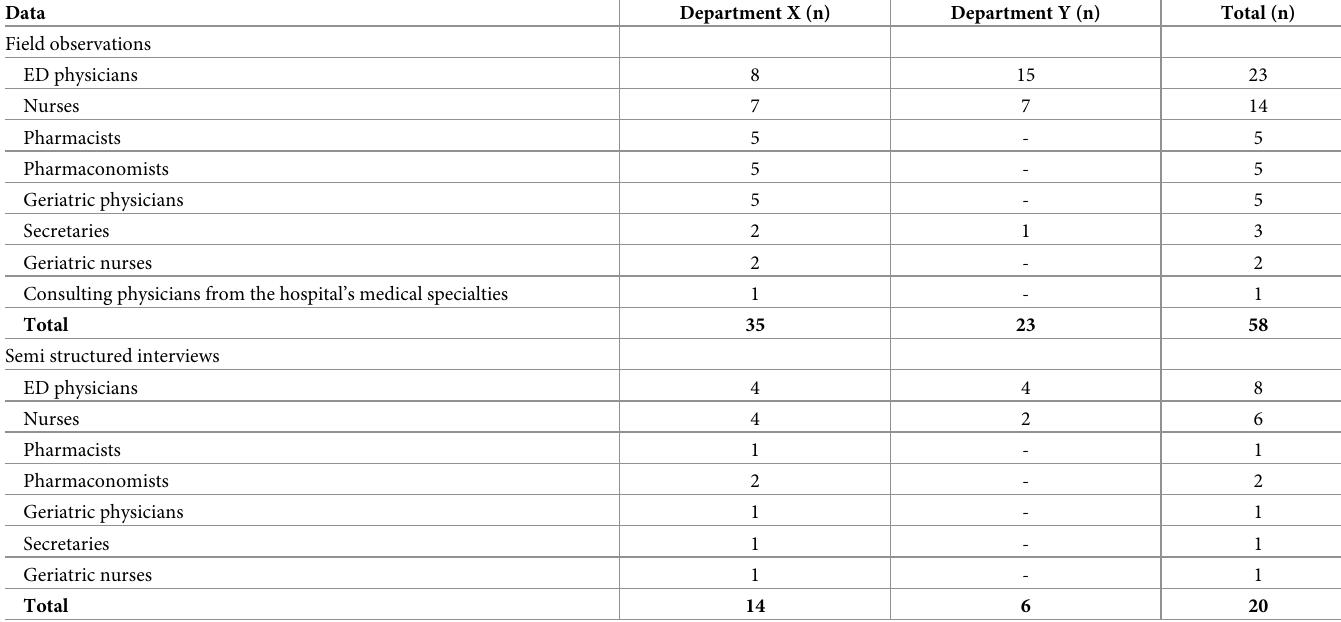
Table 2. Participant